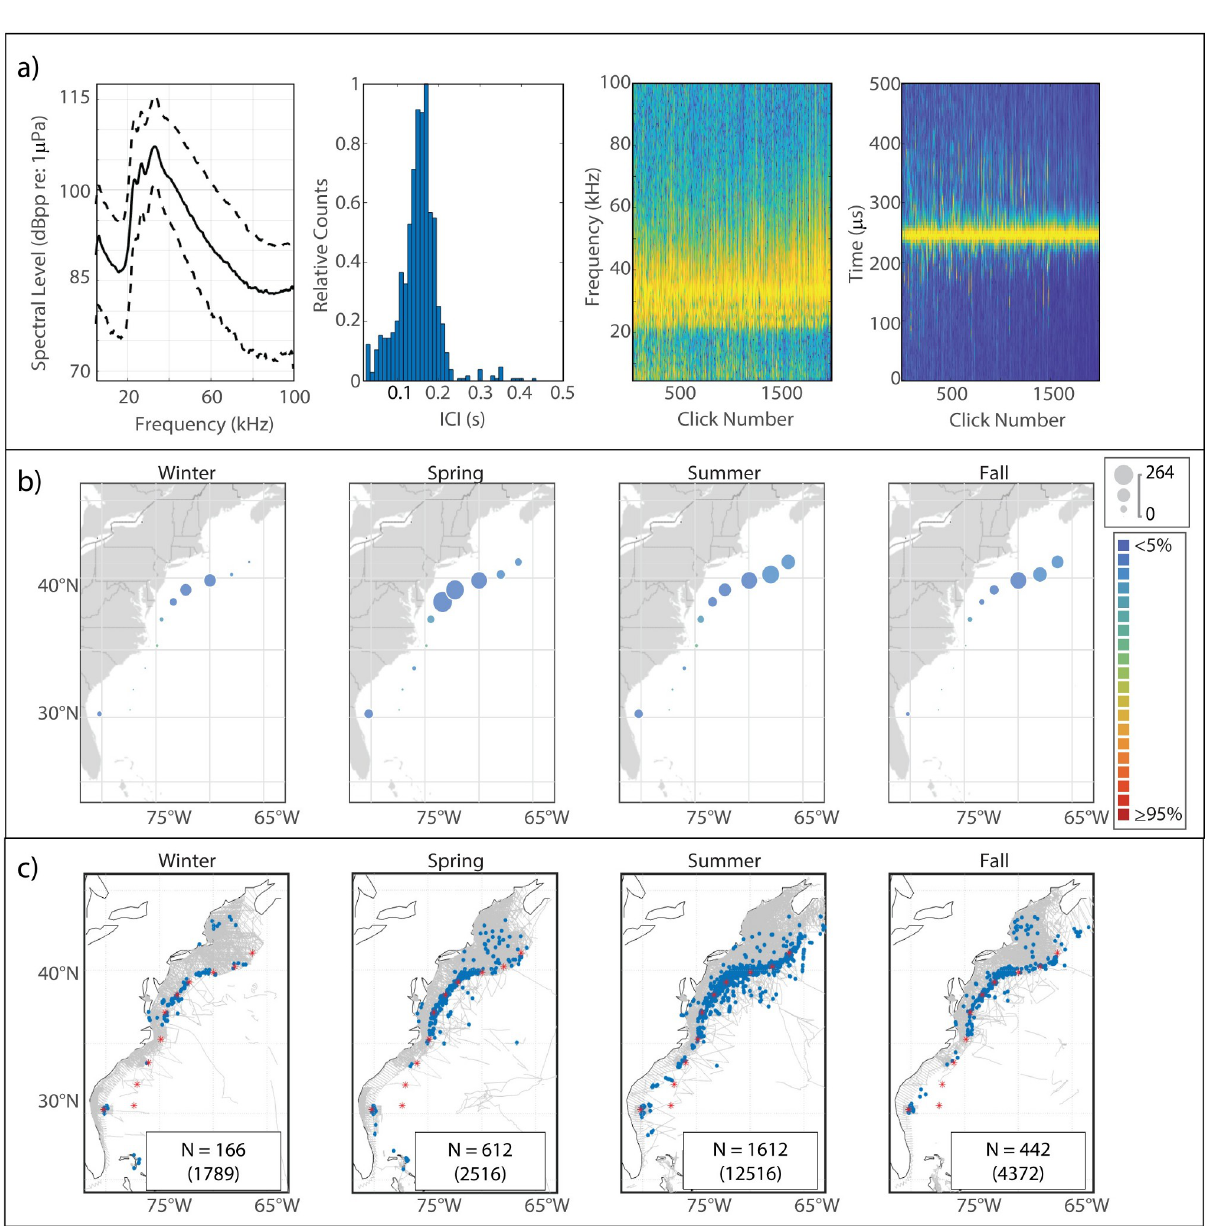
Fig 2. Results for Risso’s dolphin showing click type (a), acoustic presence (b), and historical sightings (c). Click type plots, from left to right: median power spectrum (solid line) with 10 th and 90 th percentiles (dashed lines); distribution of modal ICI values from 1,000 5-minute bins; concatenation of normalized click spectra, sorted by received level; concatenation of normalized waveform envelopes, sorted by received level. For the concatenated spectra and waveform envelopes, the normalized magnitude of the frequency/pressure is represented by color such that warmer colors show greater magnitude. Acoustic presence shown as scaled circles depicting cumulative hours at each acoustic monitoring site per season, averaged across three years of data; classifier error given by color per legend in (b). Historical sightings per season (blue dots), shown relative to acoustic monitoring sites (red stars) and track lines of surveys undertaken in each season (grey lines). Inset within each sighting map shows number of sightings (N); total number of individuals summed across all sightings for which group size data was available is shown in